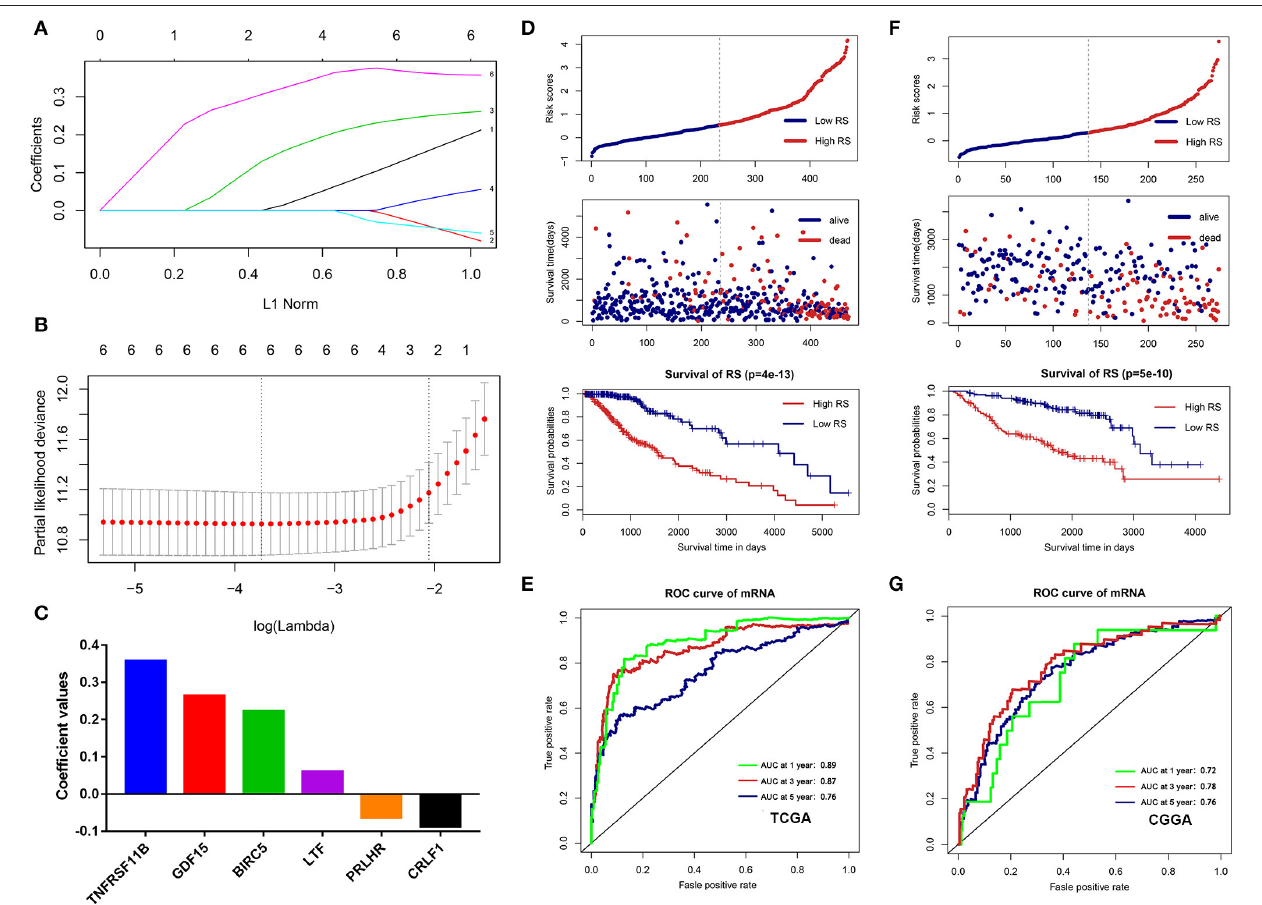
FIGURE 7 | Construction and validation of the immune-related risk score system. (A,B) The six hub genes were all selected by LASSO Cox analysis in TCGA dataset. (C) Coefficient values for each gene. (D) Kaplan-Meier curves of the OS, risk scores distribution and survival status of each patient in the training cohort (TCGA dataset). (E) Time-dependent ROC curve analysis of the immune-related risk score system in the training cohort (TCGA dataset). (F) Kaplan-Meier curves of the OS, risk scores distribution and survival status of each patient in the validation cohort (CGGA dataset). (G) Time-dependent ROC curve analysis of the immune-related risk score system in the validation cohort (CGGA